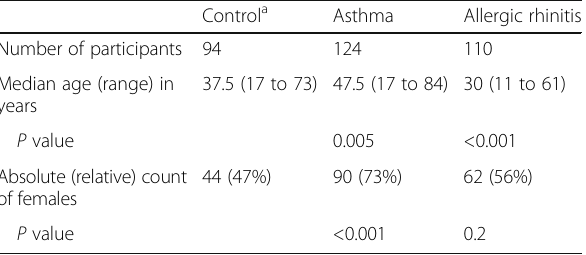
Table 1 Demographic characteristics of the study